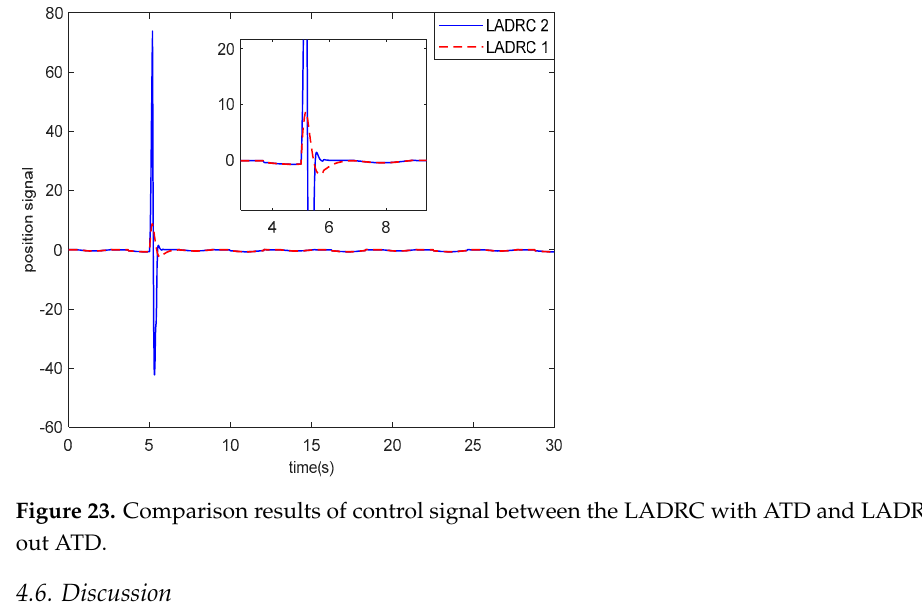
Figure 22. Step responses from the LADRC with ATD and LADRC without ATD.